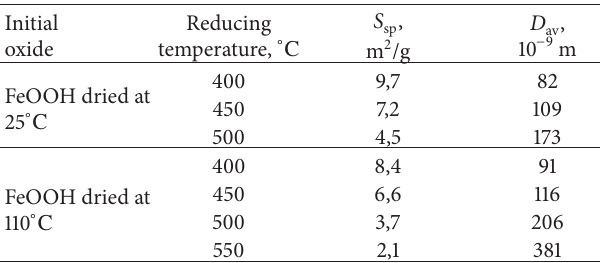
Table 1: Specific surface and average size of aggregates of fine dispersed iron reduced at different temperatures.